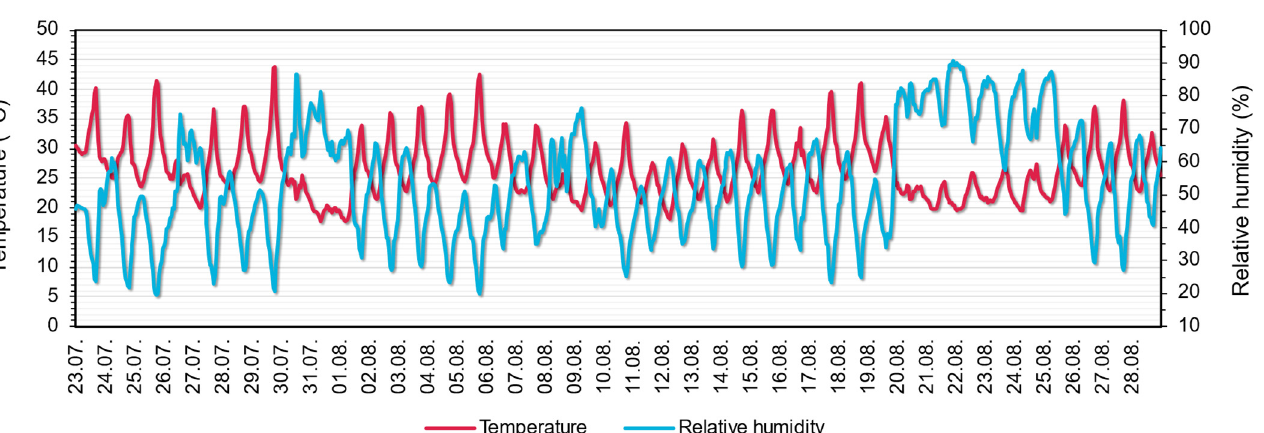
Figure 10. Measured temperature values within the apartment, including the 26 °C regulatory threshold temperature.